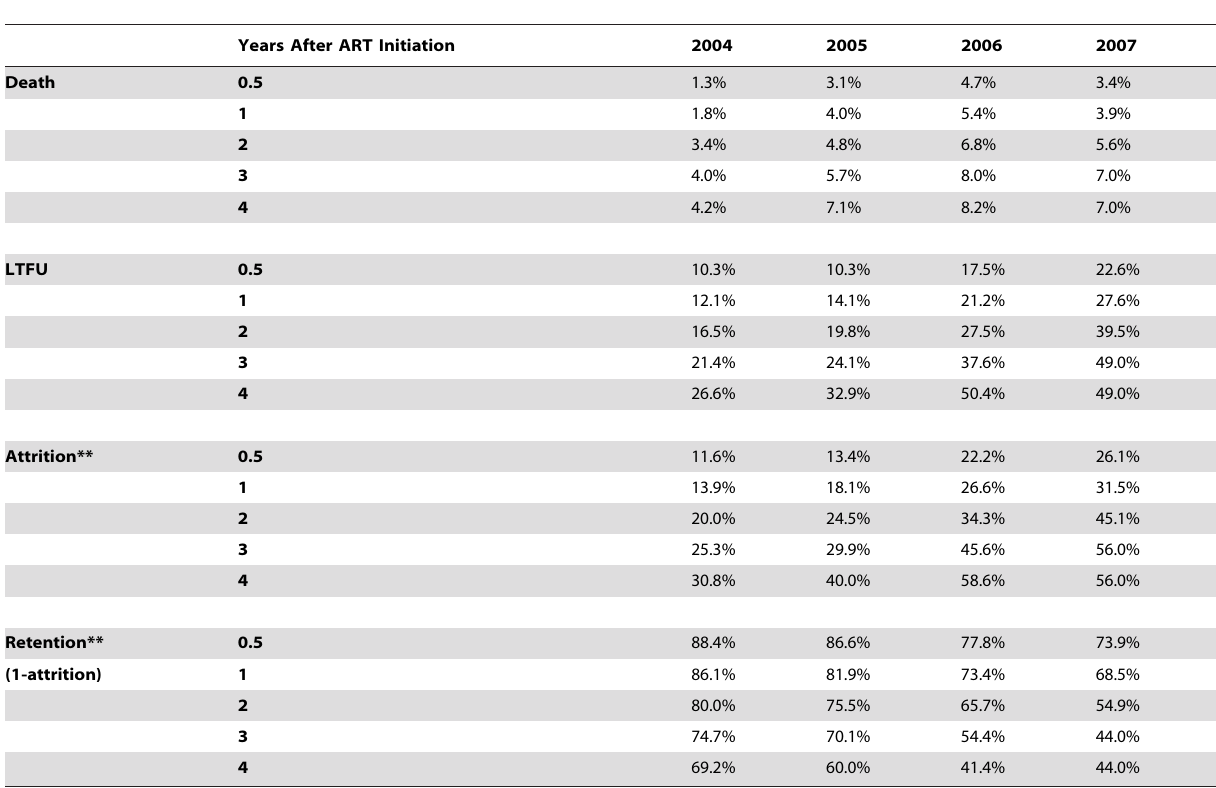
Table 3. Incidence of Death and Lost to Follow-up among Adult ART Enrollees in Coˆte d’Ivoire during 2004–2007 by Calendar Year of ART